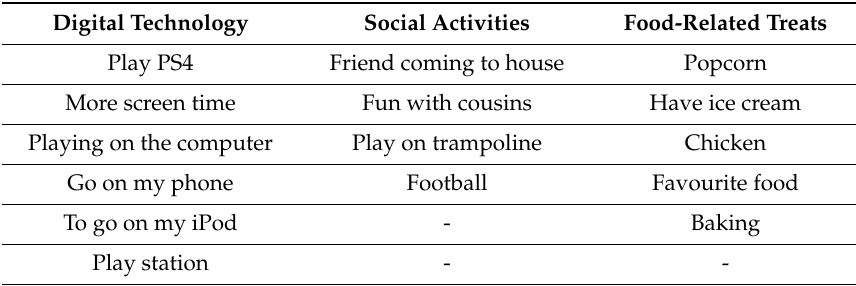
Table 5. Rewards children selected for themselves, to recognise their progress, were categorised within three